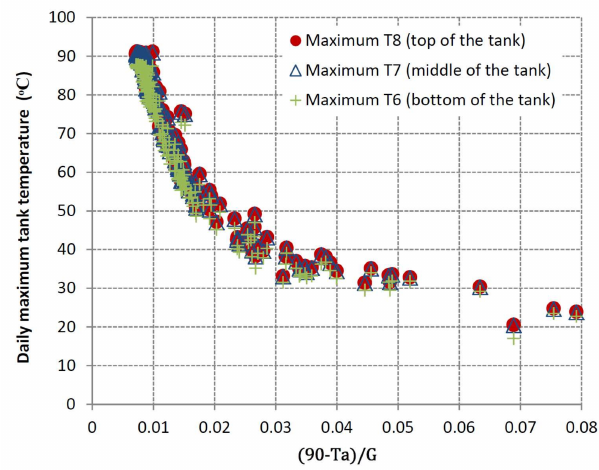
Figure 5. Maximum temperature reached in the